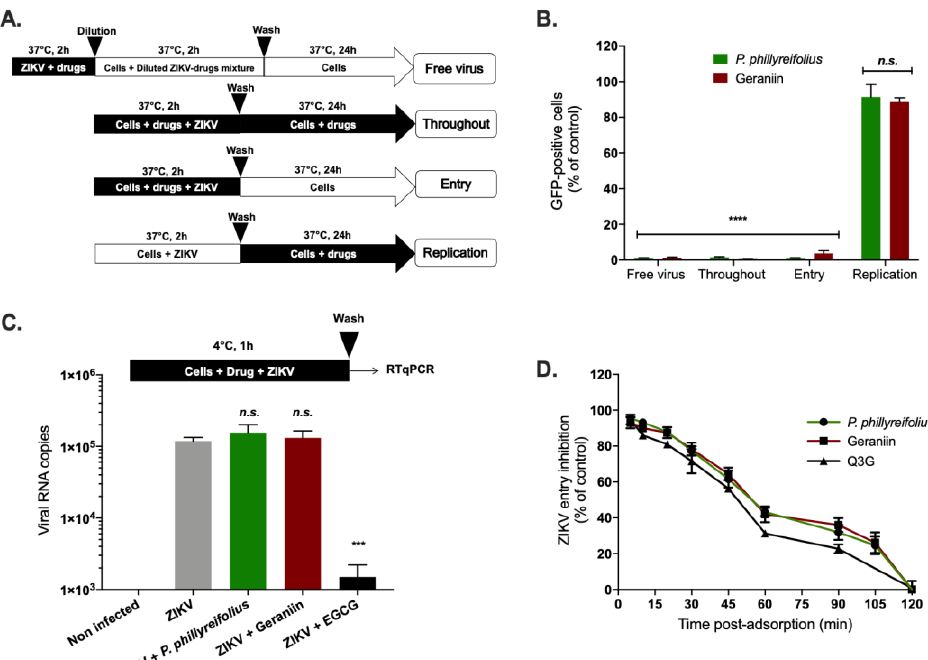
Figure 4. Phyllanthus phillyreifolius extract and its major component geraniin target the early stage of ZIKV infection. ( A ) Schematic representation of time-of-drug addition assays used to characterize the antiviral activity of P. phillyreifolius extract (250 µg/mL) and geraniin (200 µg/mL). ( B ) flow cytometric analysis of GFP expression in A549 cells infected with ZIKV GFP during 24 h at MOI of 1 under the different experimental conditions shown in ( A ). ** p <0.01; *** p <0.001, **** p <0.0001, n.s. = not significant. ( C ) A549 cells were infected with ZIKV at MOI of 1 for 1 h at 4 °C with or without P. phillyreifolius (250 µg/mL) or geraniin (200 µg/mL). Epigalocathechin gallate (EGCG) (100 µM) was used as positive control. The number of virus particles bound to cell surface was measured by RT-qPCR. ( D ) A549 cells were incubated 1 h with ZIKV GFP at 4 °C and the temperature was shifted to 37 °C in absence (vehicle) or presence of 250 µg/mL of P. phillyreifolius or 200 µg/mL of geraniin which have been added at different time points post temperature shift. Q3G (200 µg/mL) was used as a positive control. ZIKV entry inhibition was calculated from the percentage of GFP-positive cells determined at 24 hpi. Data represent the means ± SD from four independent experiments performed in triplicate.